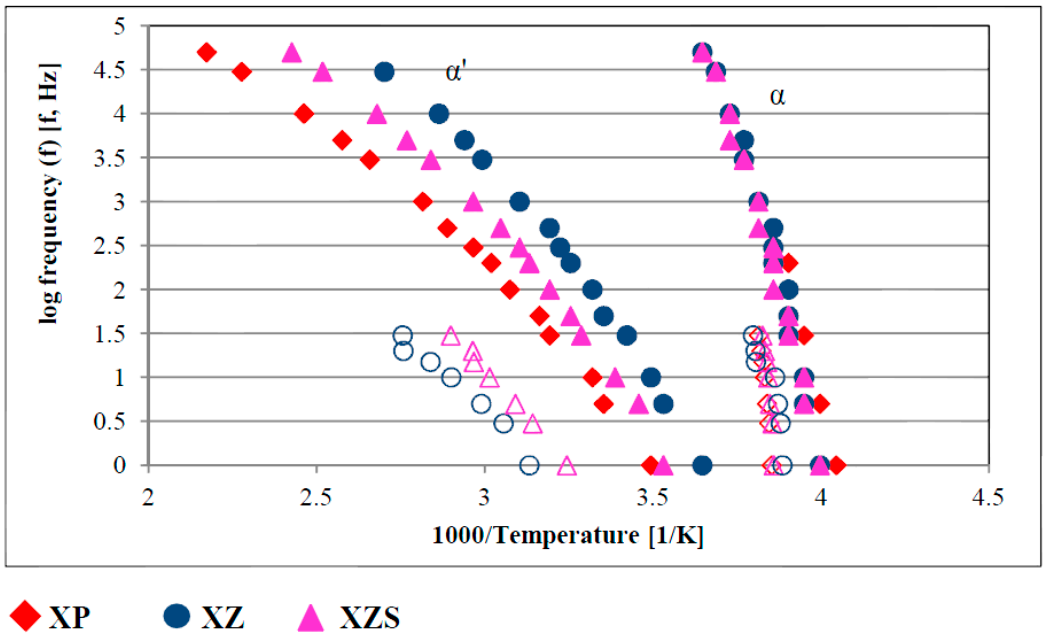
Figure 7. Activation diagrams of XNBR vulcanizates containing different crosslinking agents (full points—DRS and open points—DMA).